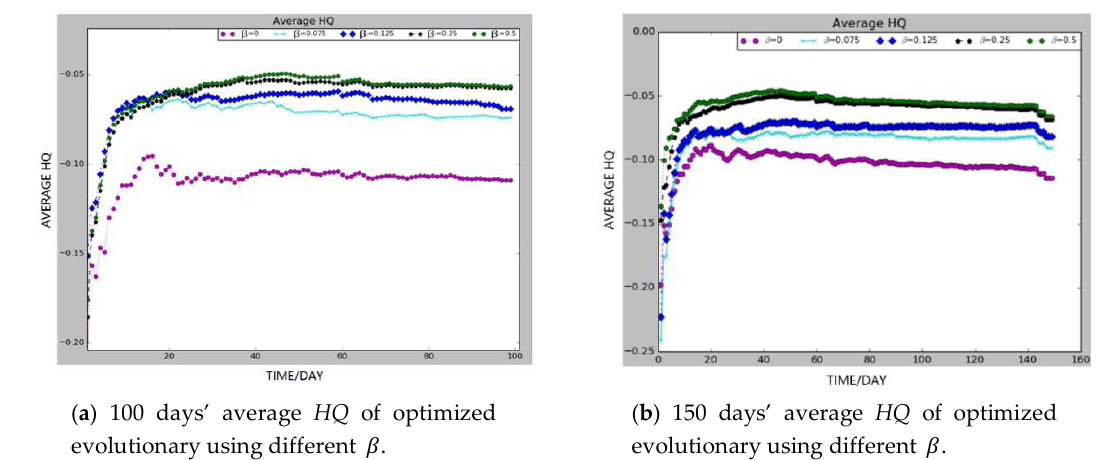
Figure 12. One-year average SQ of optimized evolutionary using different 𝛽 in LD2011_2014 dataset .